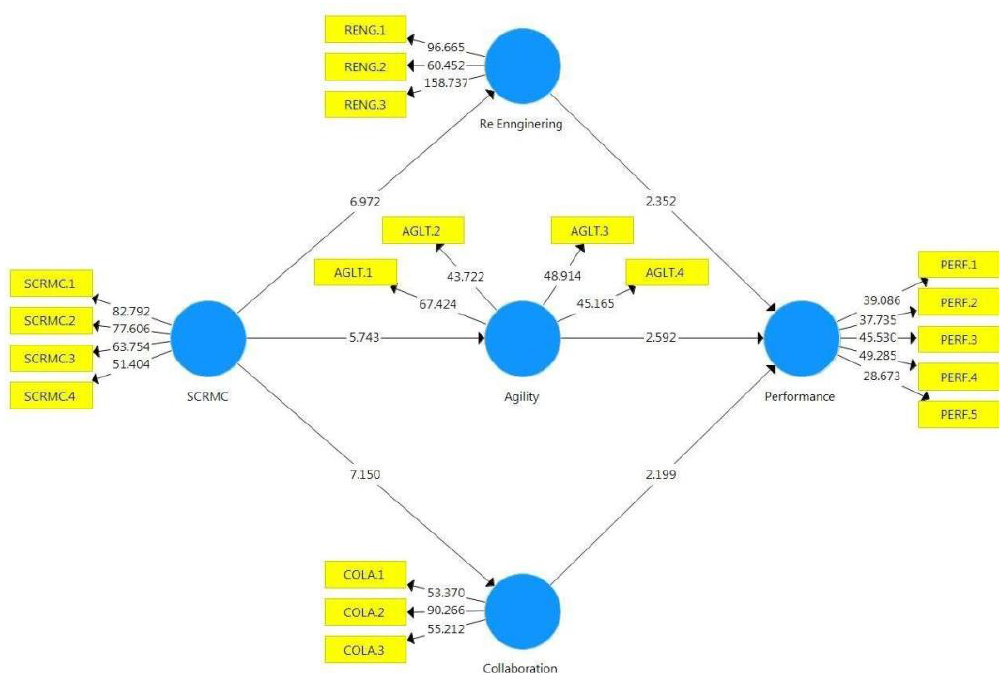
Figure 2: Path coefficients; Source: Data is